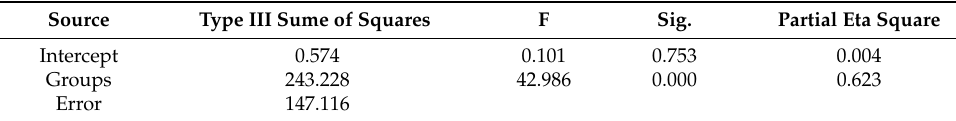
Table 7. Tests of Between-Subjects Effects for Low